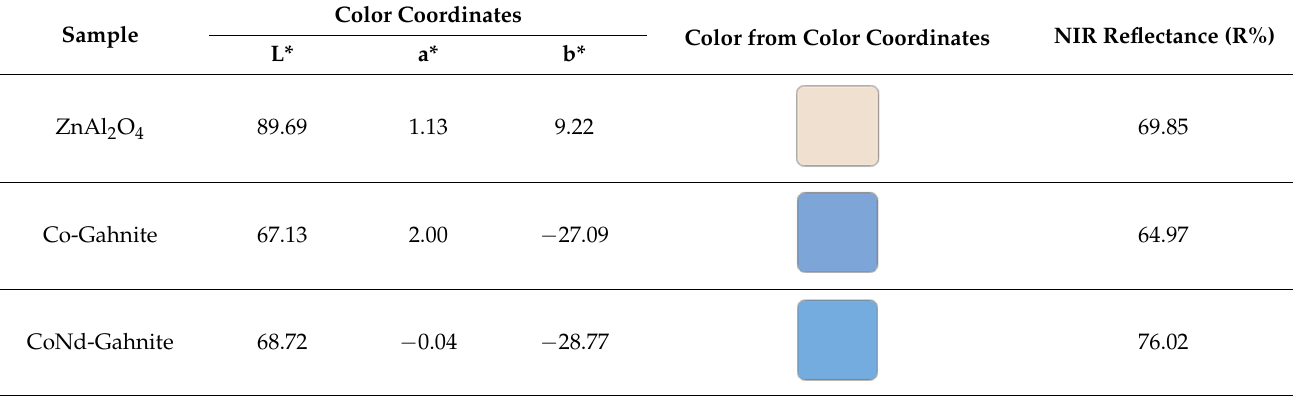
Table 3. Color coordinates, NIR reflectance of the pigments dispersed in commercial white paint.